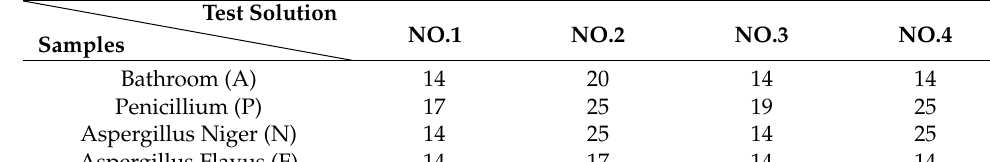
Table 9. Results of microbial test (cotton pad), diameter (mm).